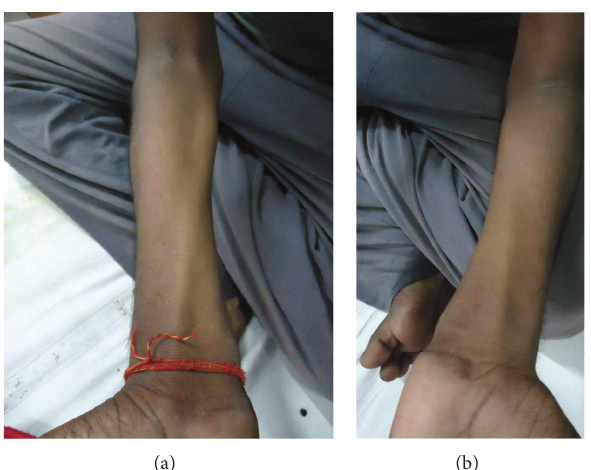
Figure 1: Symmetrical bilateral atrophy of forearm muscles with sparing of Brachioradialis.